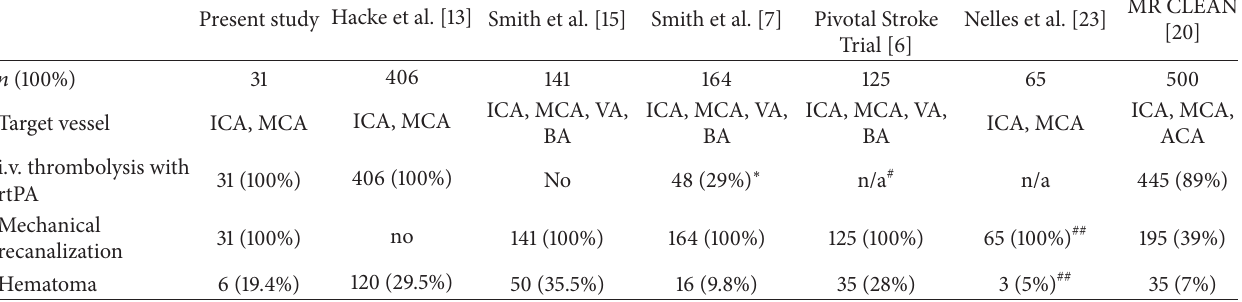
Table 2: Comparison to other